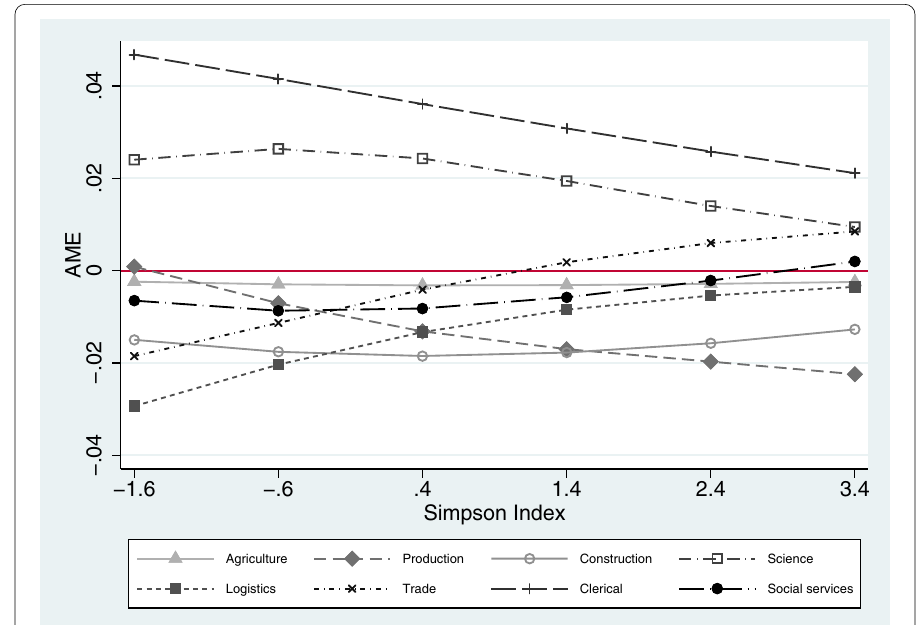
Fig. 7 Interaction of comfort preferences with the diversity index. Data source: NEPS, SC4, estimation see